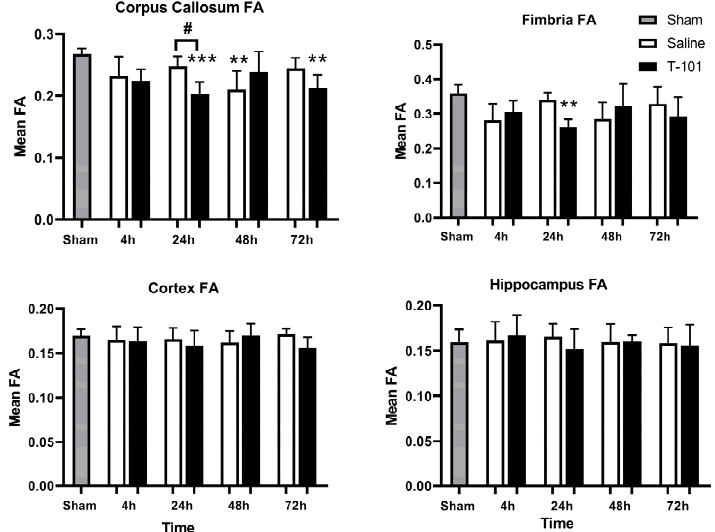
Figure 5. Diffusion tensor imaging (DTI) fractional anisotropy (FA) variation in brain regions. The greatest changes in FA were observed in the corpus callosum and the fimbria while there were no significant changes in the cortex or hippocampus. Data are plotted as the mean ± standard deviation, with significant differences from the sham for the control resuscitative fluid and T-101 groups noted by asterisks (** p < 0.005, *** p < 0.0005) and differences between injury groups for a given timepoint are noted by the pound sign (#, p < 0.05); Data compared by one-way ANOVA and the Bonferroni multiple comparison test. The analyzed groups included five animals (n = 5) per timepoint for the control and T-101 resuscitative fluid groups; five animals were analyzed in the sham group. Brain immunohistochemistry showed similar results between the sham and injury groups in the corpus callosum and overlying cortex, and the fimbria (Figure 6). Glial fi- brillary acidic protein (GFAP) staining in the corpus callosum and fimbria of the T-101 group was generally lower than the control resuscitative fluid group from 24 to 72 h, with about a 50% reduction from the T-101 group mean compared to the control resuscitative fluid group mean, although these differences were not significant. In the hippocampus, there was increased Nissl substance for the T-101 group compared to the sham group and the control resuscitative fluid group at 48 h.